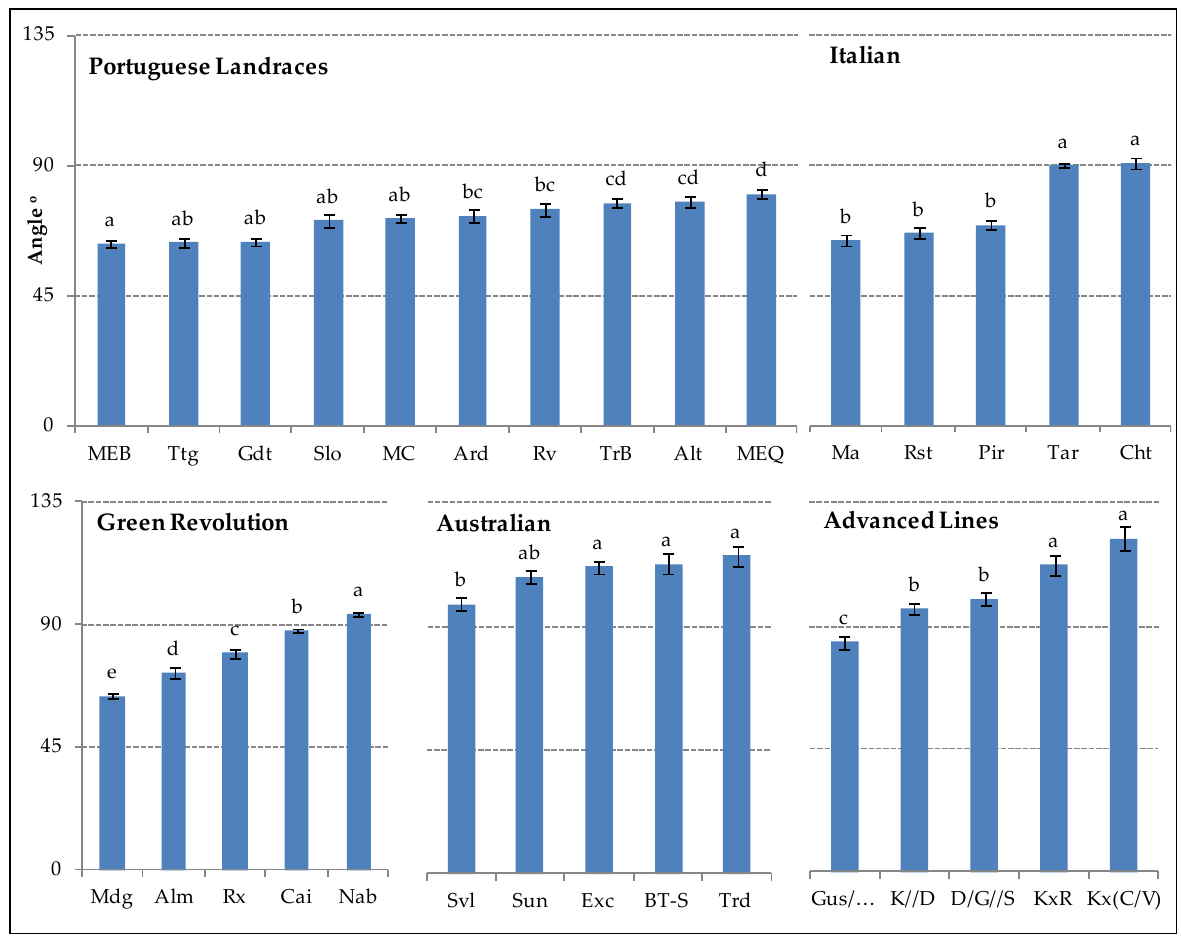
Figure 1. Root growth angle (RGA, °) between the first pair of lateral seminal roots of 30 bread wheat genotypes belonging to five evolutive/breeding groups. For each genotype, the mean values ± SE ( n = 60) followed by different letters express significant differences (a, b, c, d, e) for a 95% confidence level. The highest value corresponds to the letter a.